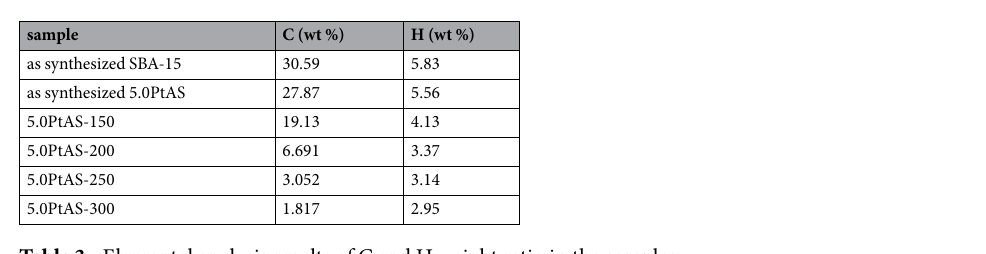
Table 3. Elemental analysis results of C and H weight ratio in the